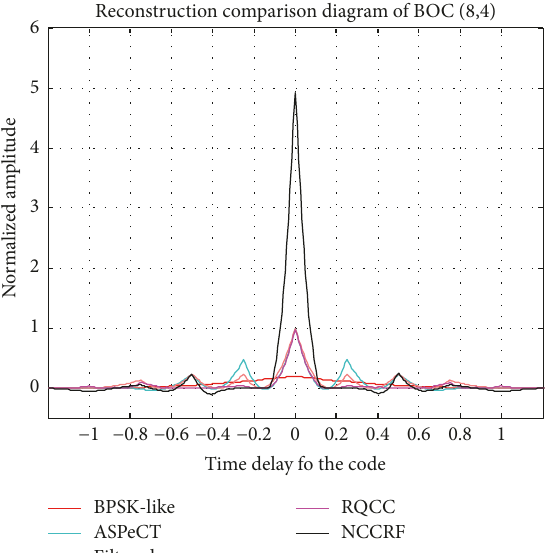
Reconstruction comparison diagram of BOC (8,4)